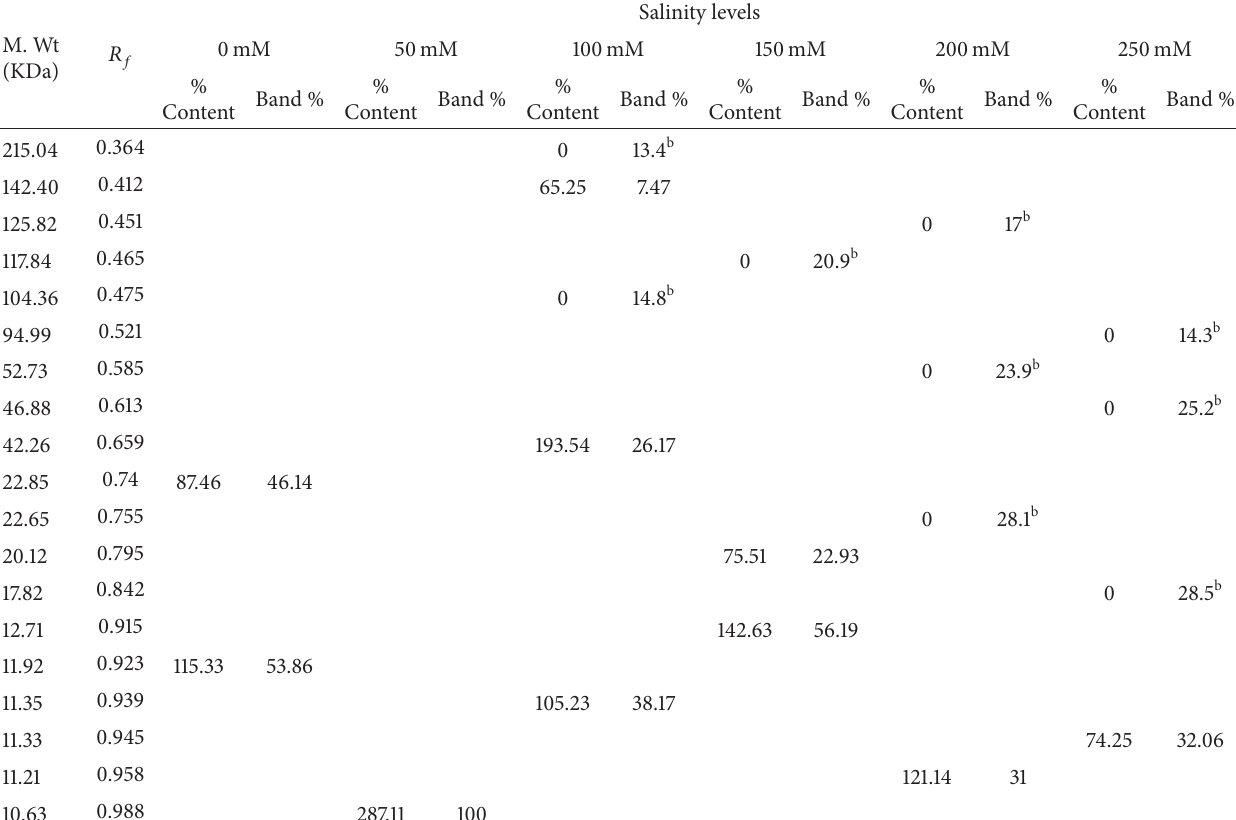
Table 4: Electrophoretic protein pattern of salinity stressed Triticum aestivum seedlings presoaked in 10% Ulva lactuca extract.